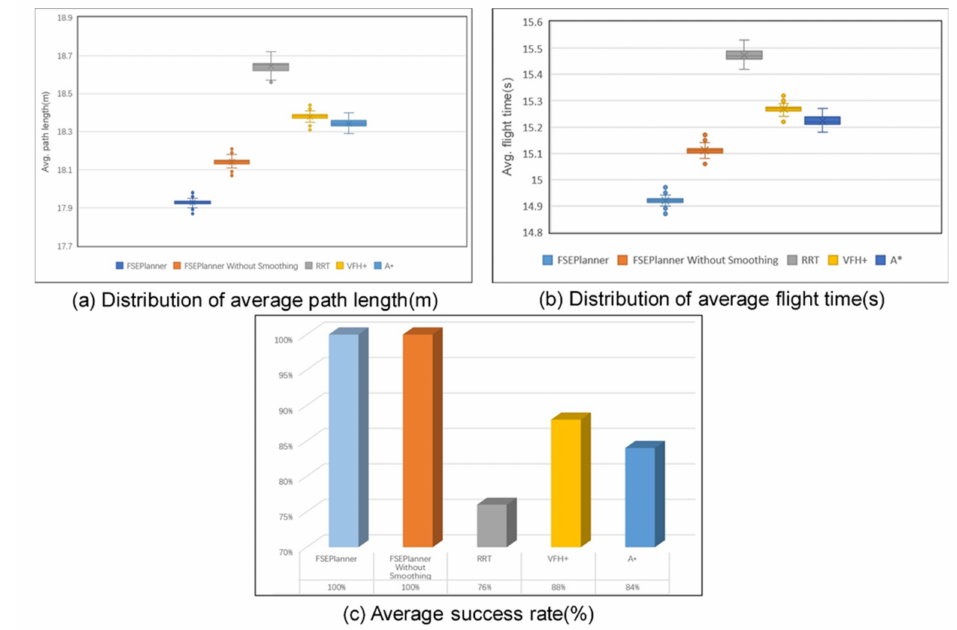
Figure 20. Results of the comparisons between the RRT, A*, VFH+, proposed FSEPlanner without Smoothing and FSEPlanner algorithm in ( a ) Distribution of average path length (m), ( b ) Distribution of average flight time (s) and ( c ) Average success rate (%) in maze